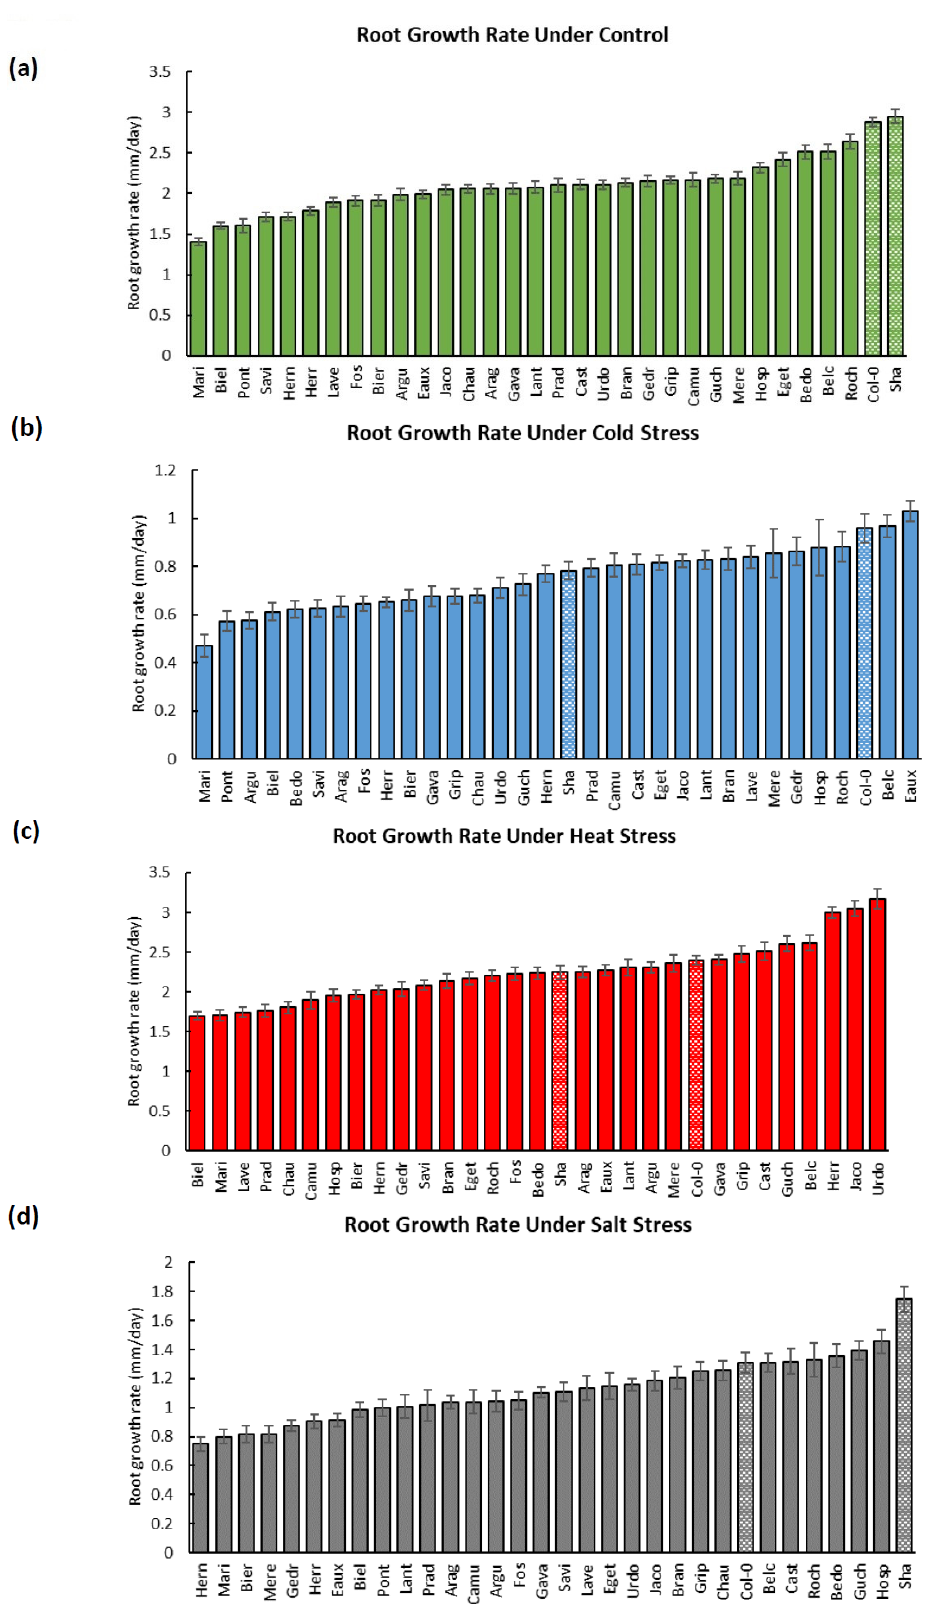
Figure A1. Line graphs displaying the primary root length (PRL in mm) for each population over time (days) under each growth condition (ctrl: green, cold: blue, heat: red, and salt: grey). The error bars present the standard error of means.